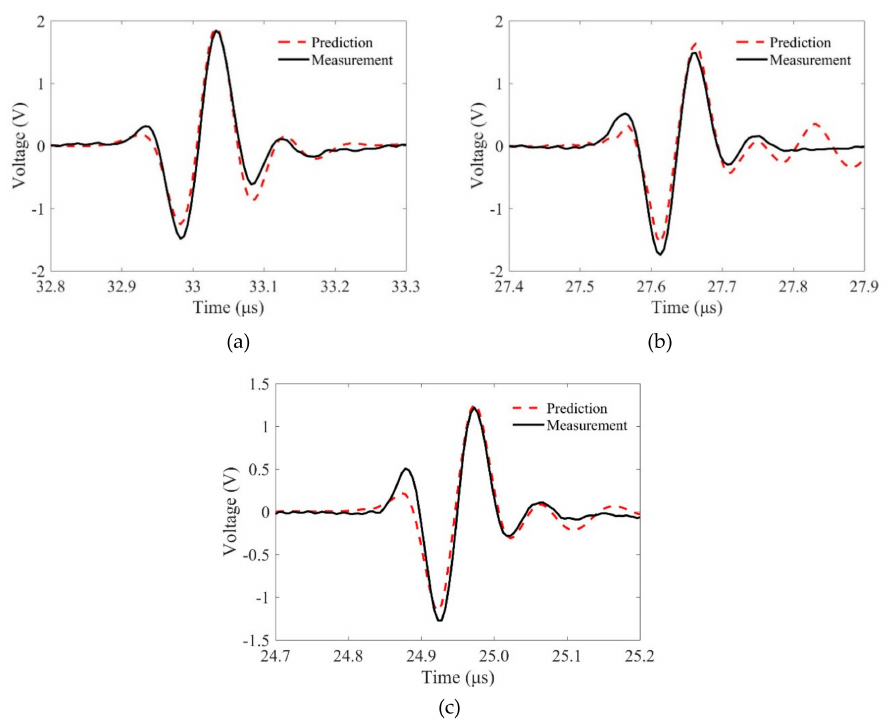
Figure 11. Comparisons of the flaw signals between predictions and measurements at incidence angle of θ p 1 = 10 ◦ when the radii of curvature are ( a ) R = ∞ , ( b ) R = 50 mm, and ( c ) R = 30 mm.